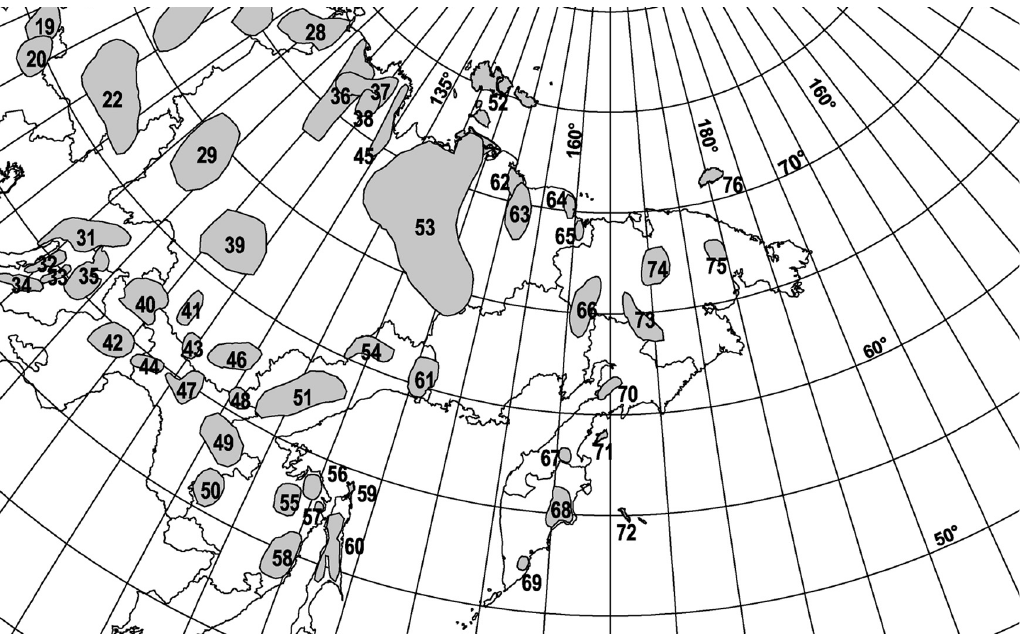
Fig. 3. Reindeer populations (Nos. 36-76) in Far East of Russia (I.D. No. in figure correspond to the I.D. No. for populations listed in Tables 1 and